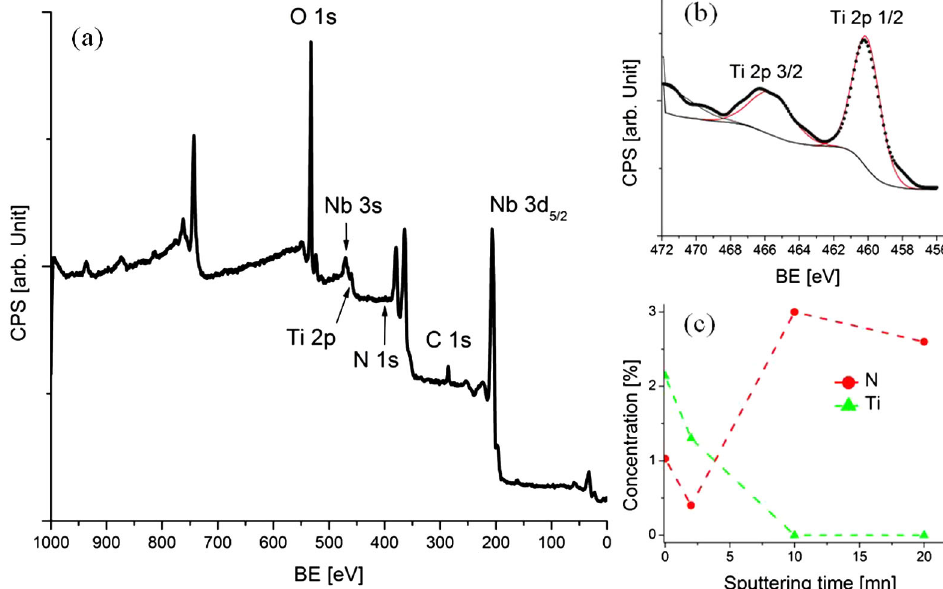
FIG. 21. The XPS spectrum of sample L50 (a) shows the niobium, titanium, and oxygen peaks present on the surface prior to using the sample as the sputtering target. The upper right figure (b) shows a zoomed in view of (a) around the Ti peaks where the red curve is the fit to the spectrum. The bottom right figure (c) shows the concentration of titanium (green) and nitrogen (red) measured by XPS as a function of sputtering time. After 10 minutes there is no longer any measurable titanium present, thus, the Ti impurities lie only on the surface of the